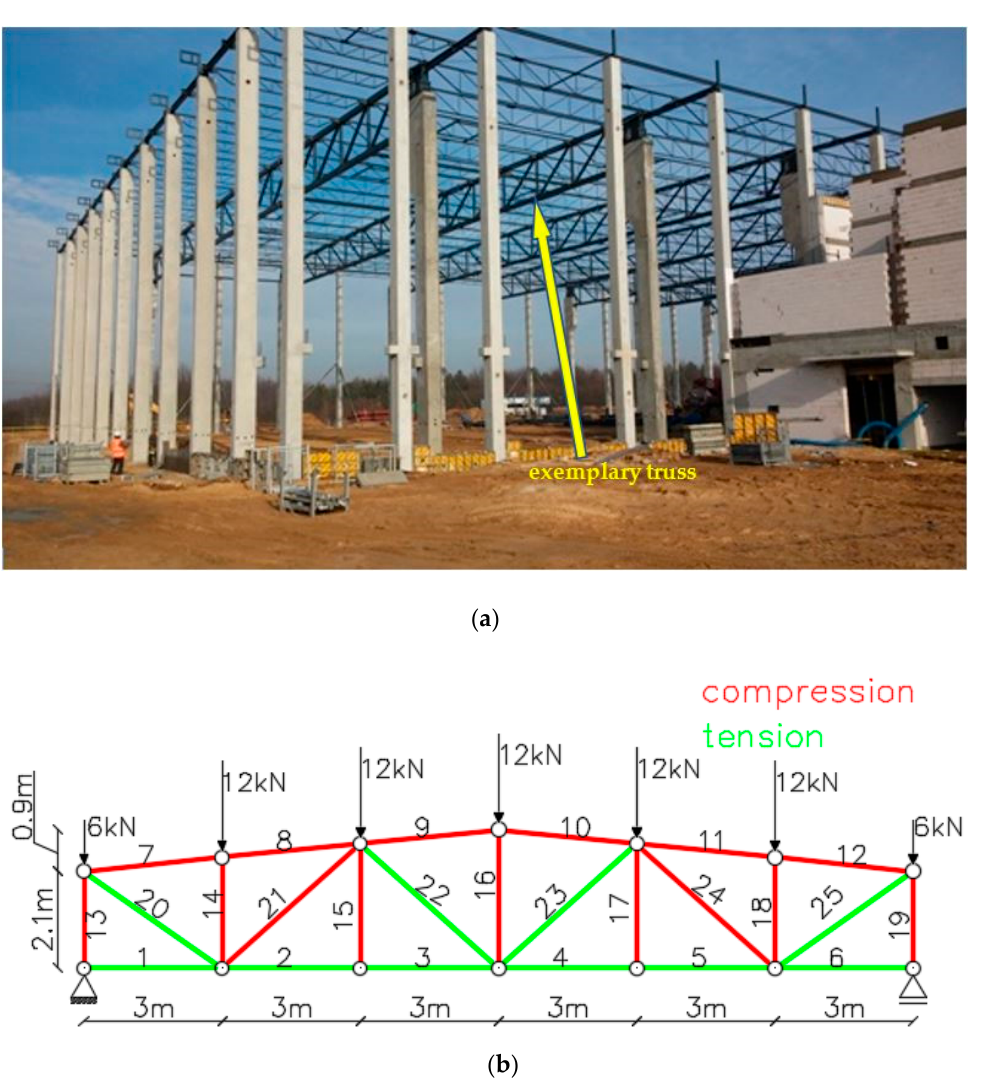
Figure 1. ( a ) Example of an industrial hall with steel lattice girders [31]. ( b ) Static scheme of the truss model. Table 2. Truss sections and the e ff ect of actions. Section E ff ect of